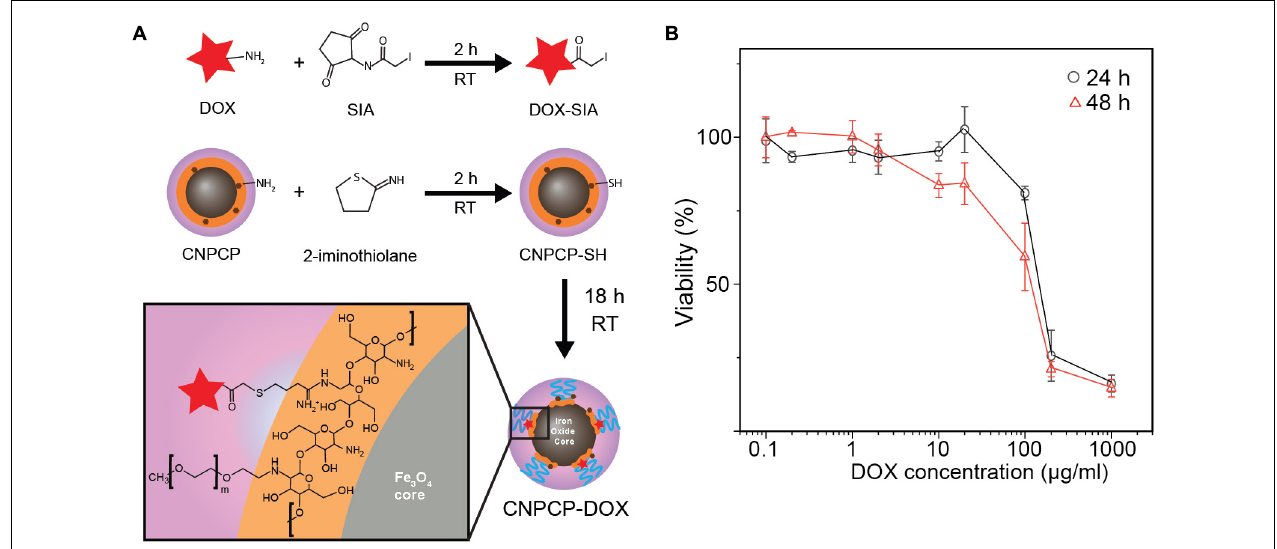
FIGURE 6 | Chemotherapeutic delivery by CNPCP. (A) Schematic representation of conjugation of DOX onto CNPCP. (B) Cytotoxicity curve of CNPCP-DOX on SF763 after 24 and 48 h